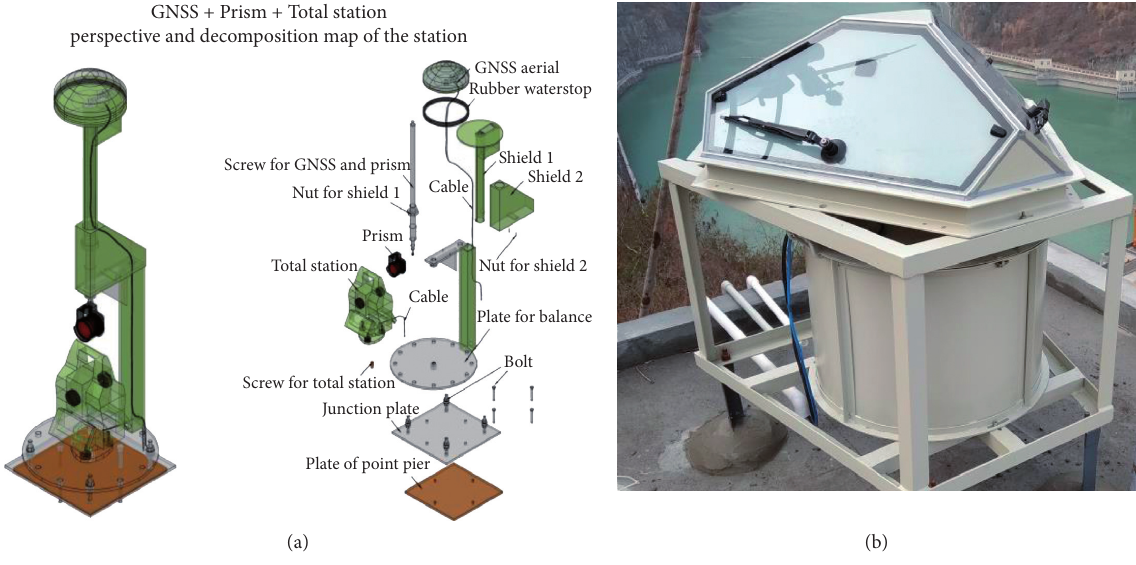
Figure 4: Diagram of the (a) TPS-GNSS and (b) the rain